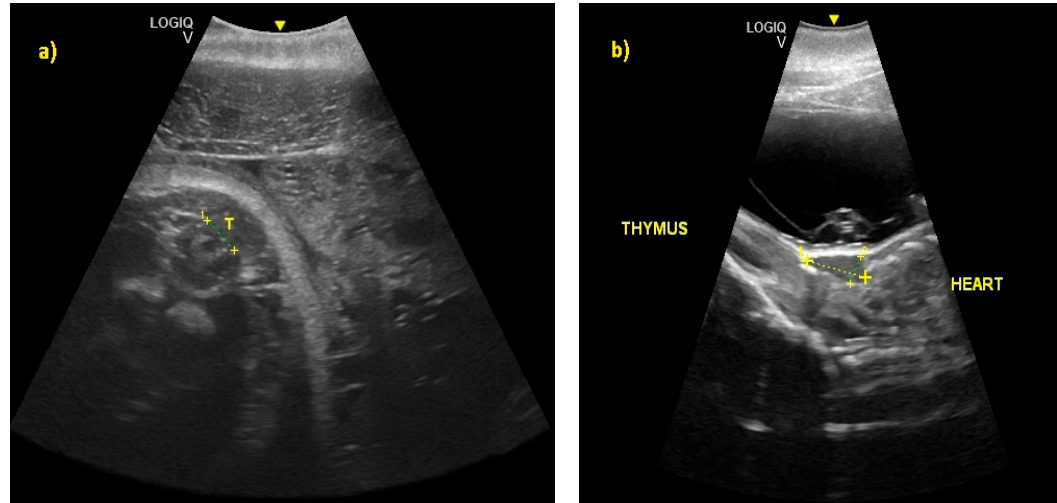
Figure 8. ( a ) At 245 ± 2 to 288 ± 2 days of gestation, it was possible to recognize the thyroid (T) and ( b ) the thymus, respectively.